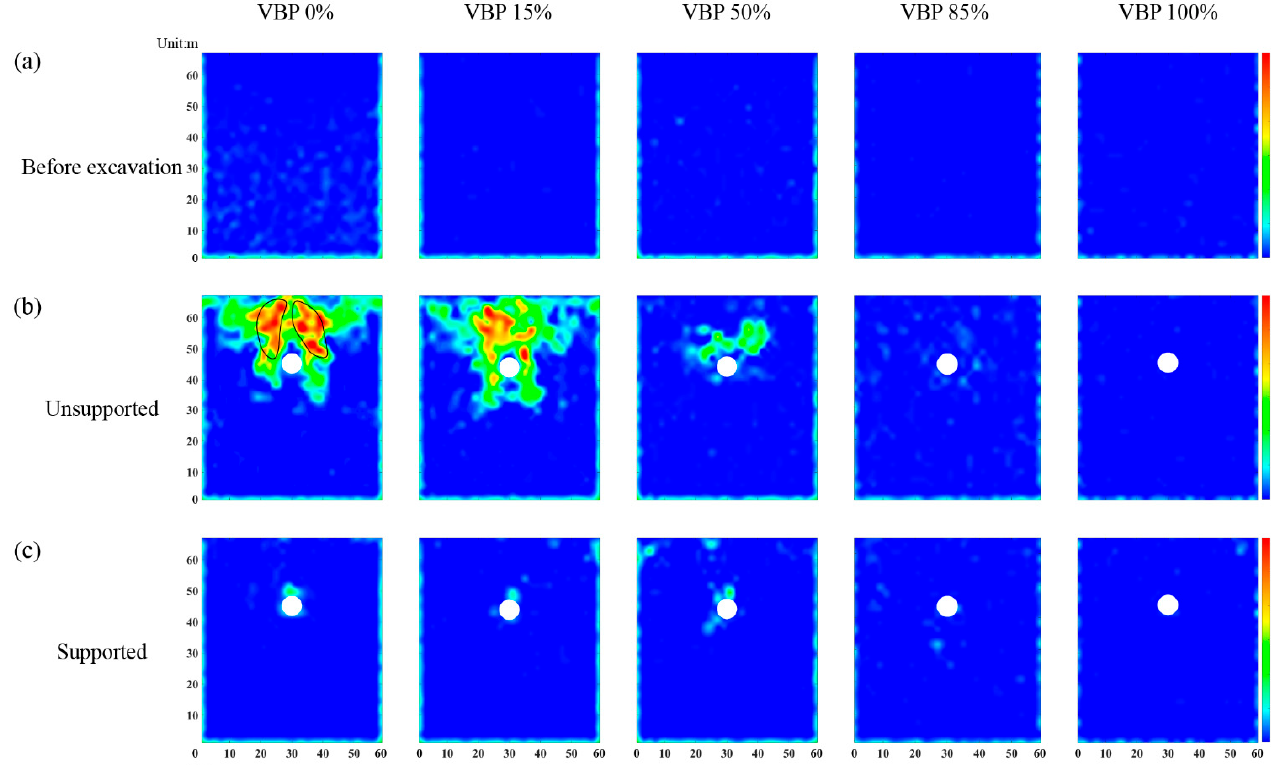
Figure 10. The distribution of shear-slip contacts in the ( a ) original state, ( b ) excavation without support and ( c ) supported excavation by lining. The black curve stands for shear band.